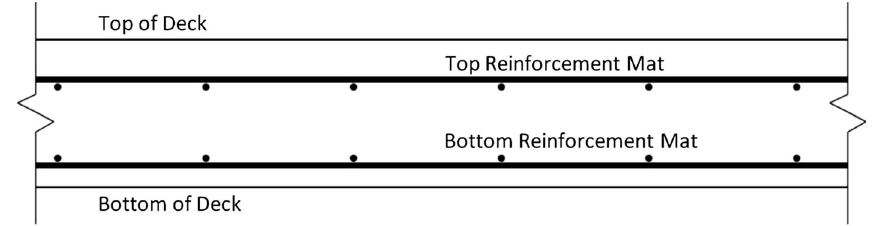
Fig. 1 Typical reinforcement placement in bridge deck.